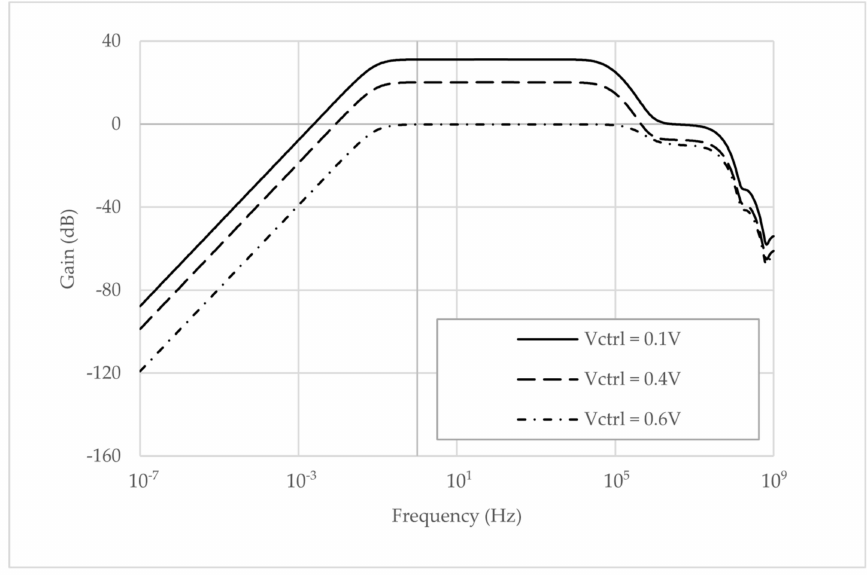
Figure 8. AC performances of the amplifier at various gain levels.